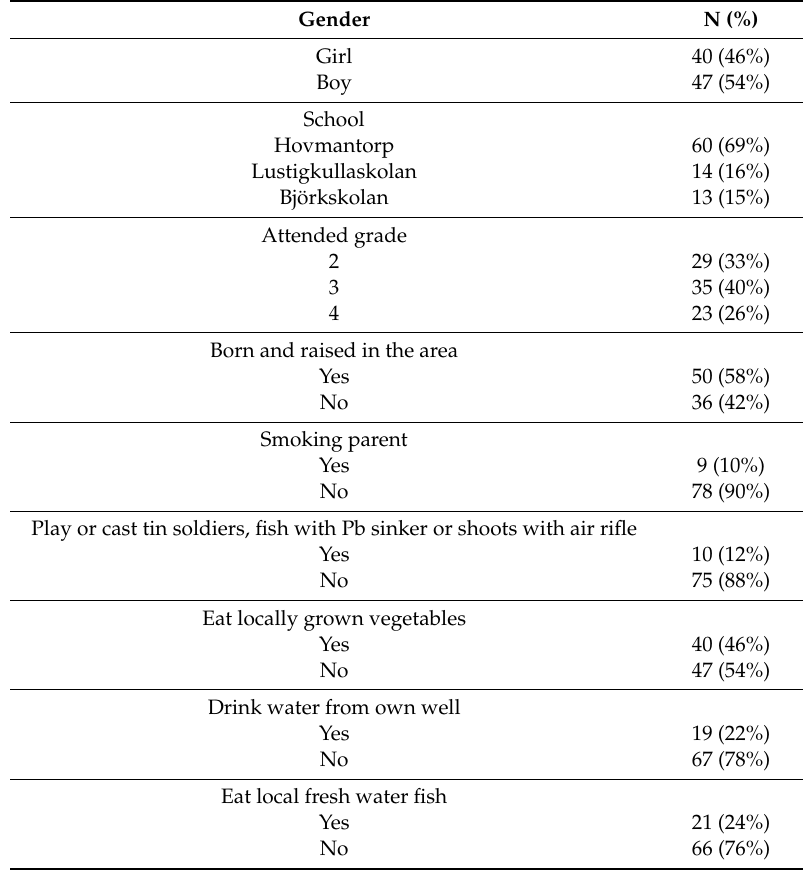
Table 1. Descriptive table for the study population based on self-reported